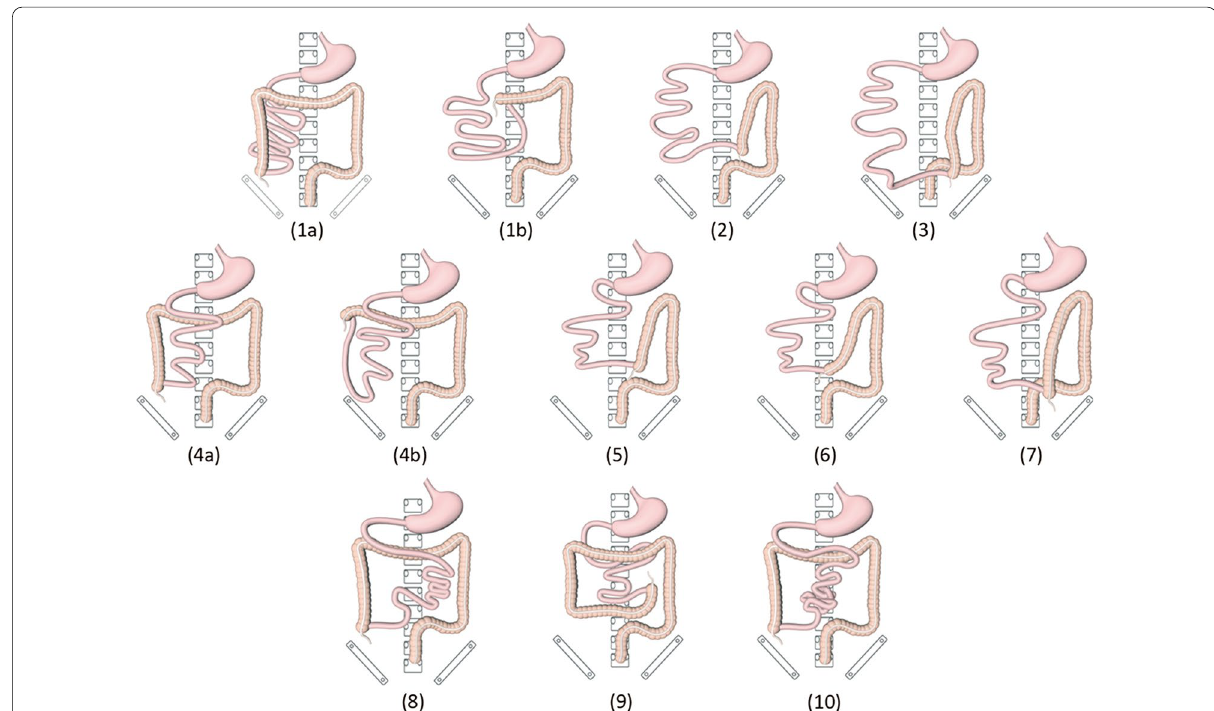
Fig. 2 Schematic diagram of the ten subtypes. ( 1a ) and ( 1b ) two cases of D N J R C R subtype: normal and high cecum; ( 2 ) D N J R C L ; ( 3 ) D N J R C P ; ( 4a ) and ( 4b ) two cases of